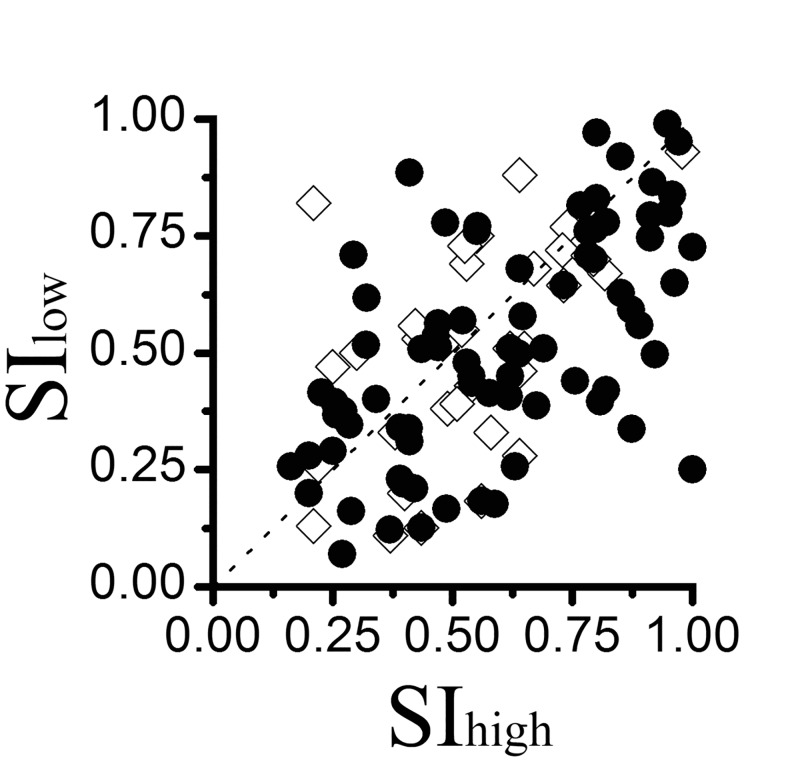
The scatter plot of the estimates of surround suppression at high contrast versus low contrast.The solid circle and hollow diamond indicate RSUs and FSUs, respectively.